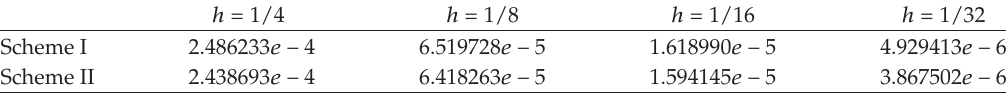
Table 1: The maximal errors of numerical solutions at t (cid:9) 10 with τ (cid:9) 0 . 1 for α (cid:9) 0 . 5 when p (cid:9) 1.